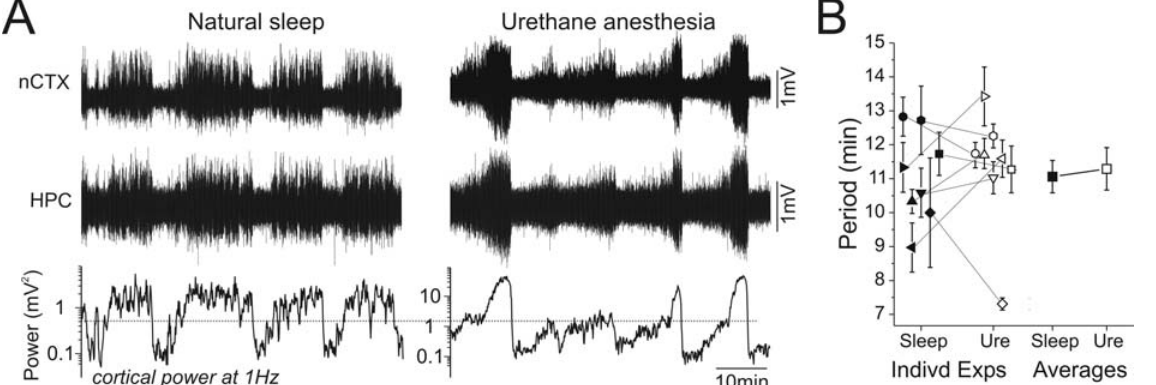
Figure 6. The timing of cyclic EEG state alternations was highly similar across naturally sleeping and urethane-anaesthetized conditions. A) Long-duration EEG traces during a continuous natural sleep episode (left panel) and subsequently from the same animal under urethane anaesthesia (right panel). Regular fluctuations between REM and nREM sleep stages were highly comparable in their timing to the state alternations later observed under urethane. Plotted on the same time scale underneath the raw traces is the respective spectrographic power at 1 Hz extracted from the cortical signals. These fluctuations demonstrated a similar rhythmicity across both conditions. B) Scatterplot representing period lengths of alternations for all animals under both naturally sleeping and urethane anaesthetized conditions. There was a remarkable similarity in the distribution and average length of alternations for each animal as well as for the overall average for natural sleeping and urethane anaesthetized conditions.